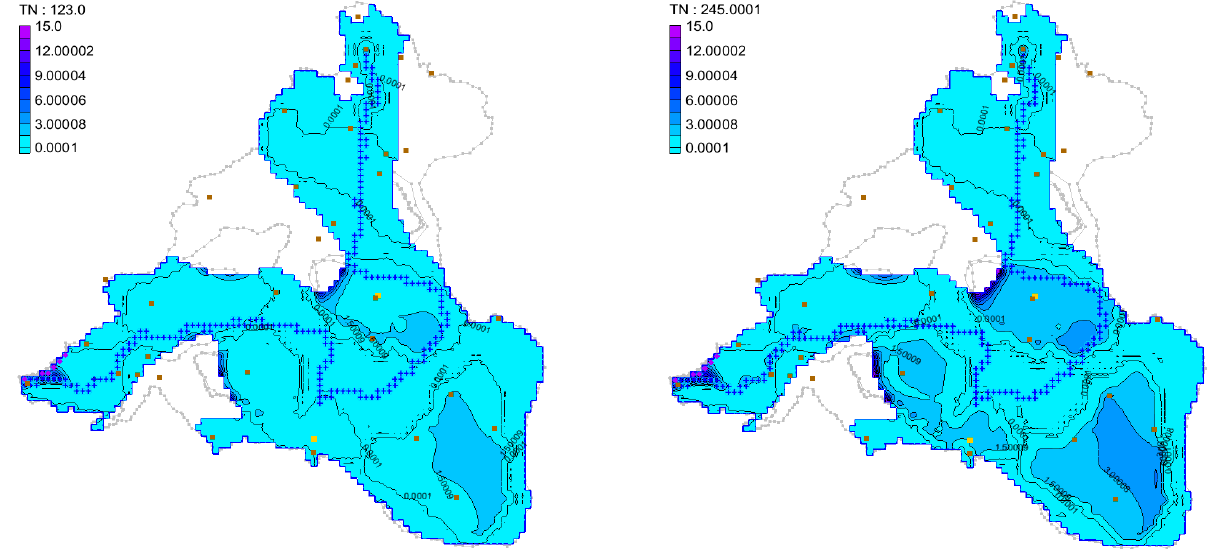
Figure 7. Scenario 3 model of 123 d and 245 d total nitrogen simulation results.